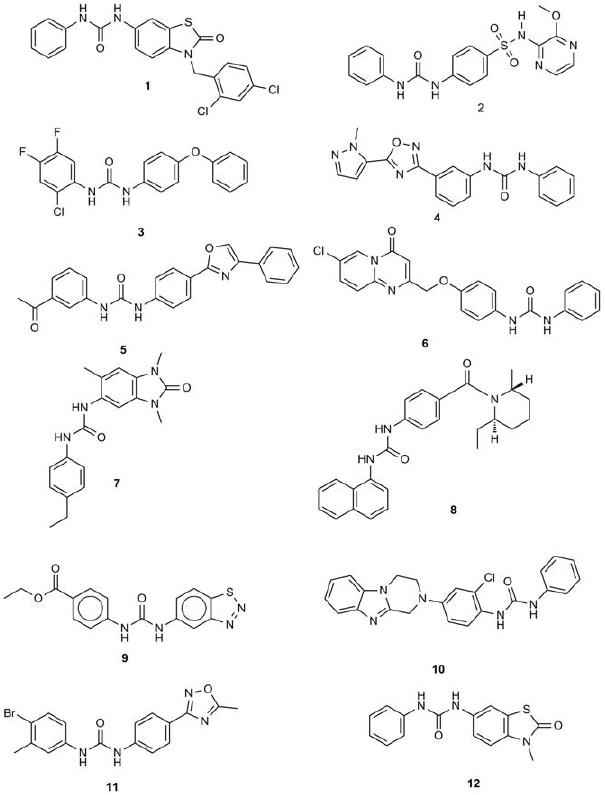
Figure 9. Structures of the hits mentioned in figure 8 as an example of the screening protocol results.